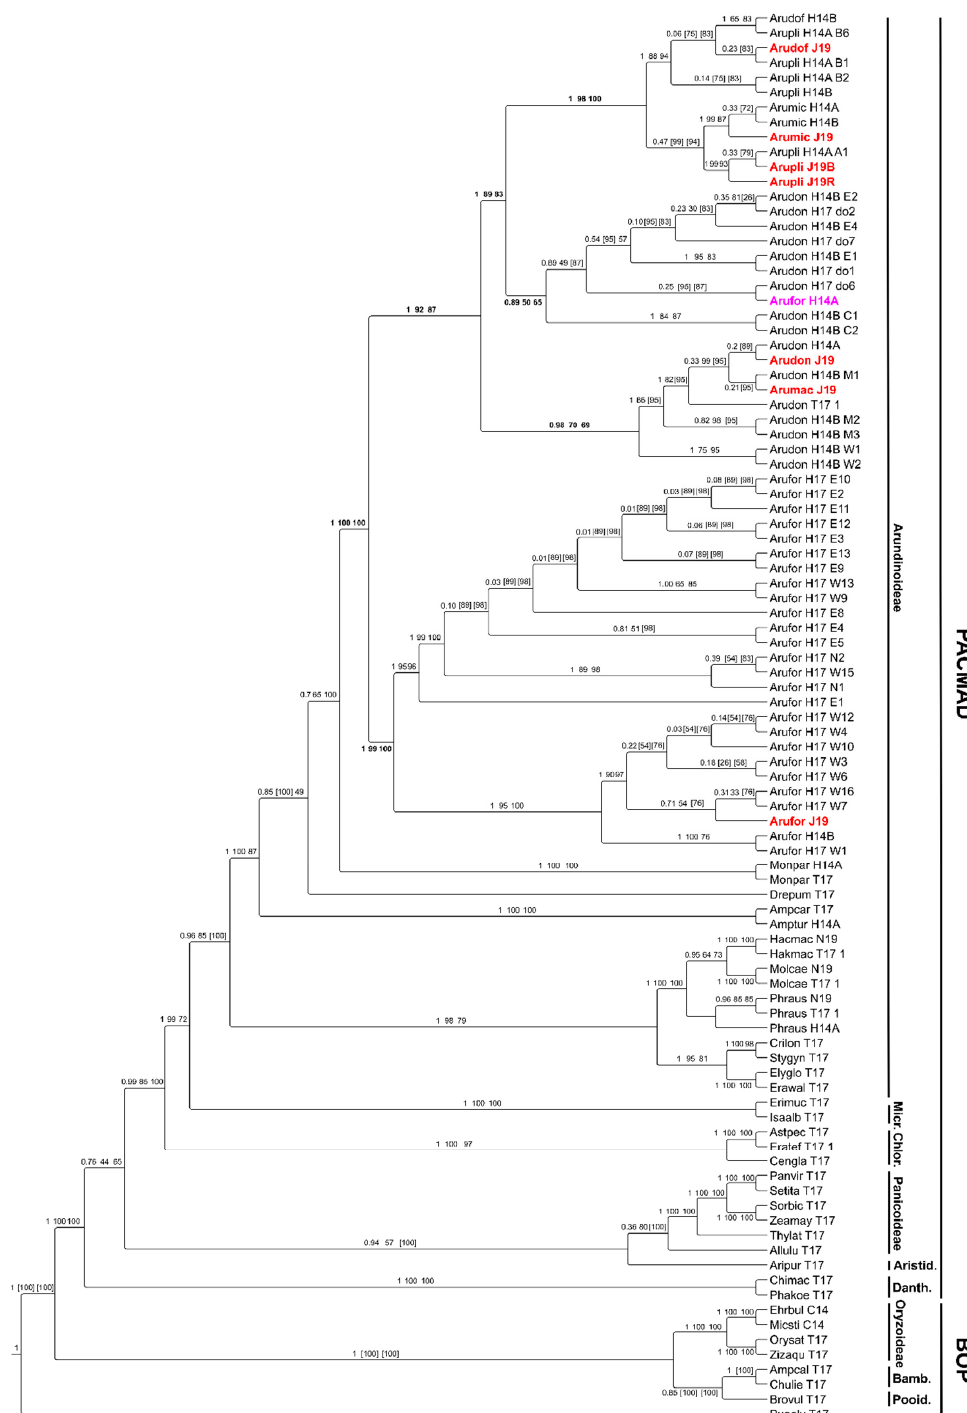
Figure 3. Combined ML and Bayesian inference (BI) cladogram of the Arundinoideae and selected species from PACMAD and BOP clades based on 5 chloroplast intergenic regions. Taxa in red are those used in this study for leaf RNA-Seq. The taxon in purple corresponds to the misidentified A. formosana accession used in Hardion et al. 2014. Branch supports are poster support from BI analysis (first number) and ultrafast bootstrap support from ML analysis (second number). The reference topology is obtained by BI. Numbers in square brackets indicate the support for the alternative ML topology. Cladogram drawn with Tree Graph